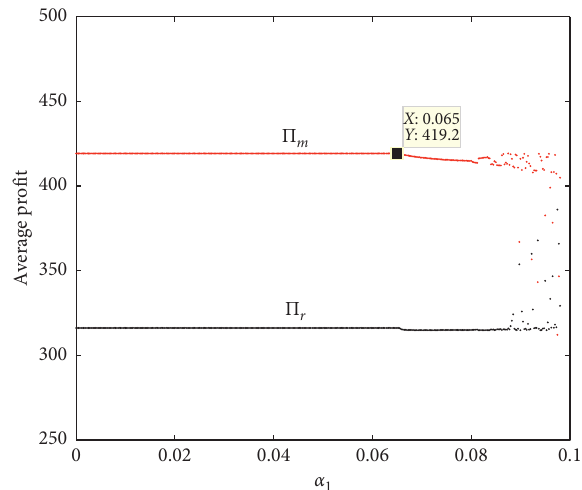
Figure 13: The average profit diagram with respect to α